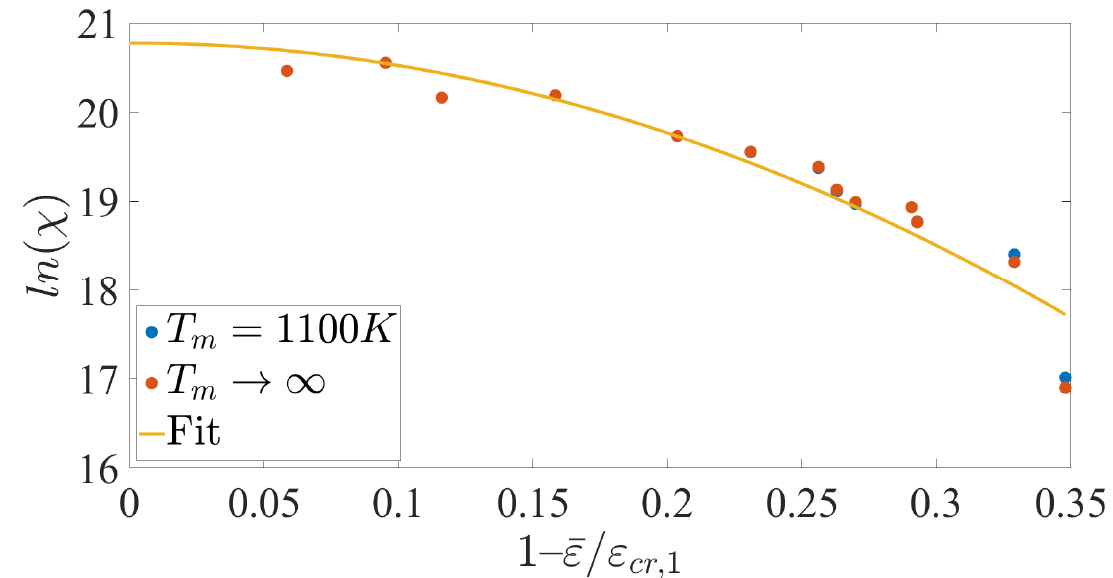
⁄ (cid:3439) for two different values of 𝑇 (cid:3117)